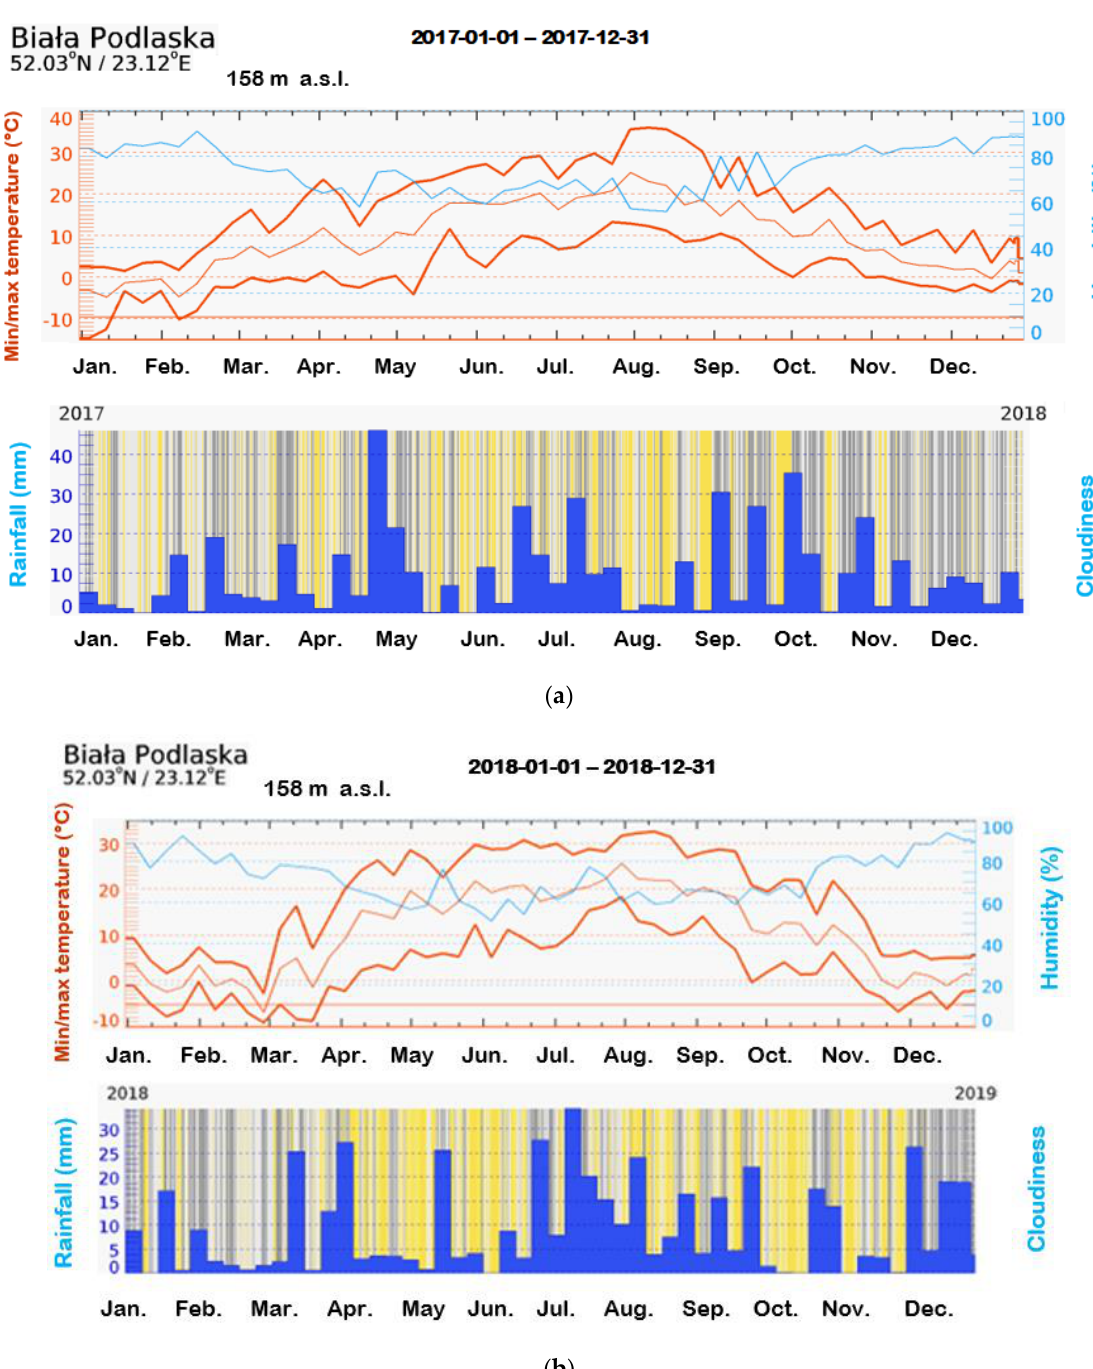
Figure 1. Meteorological conditions in Biala Podlaska during ( a ) the first and ( b ) second year of the experiment. Data shown are from the Meteoblue website: https://www.meteoblue.com/ (accessed on 29 August 2021). data from 2017—the 10th of January 2018, data from 2018—the 8th of January 2019.